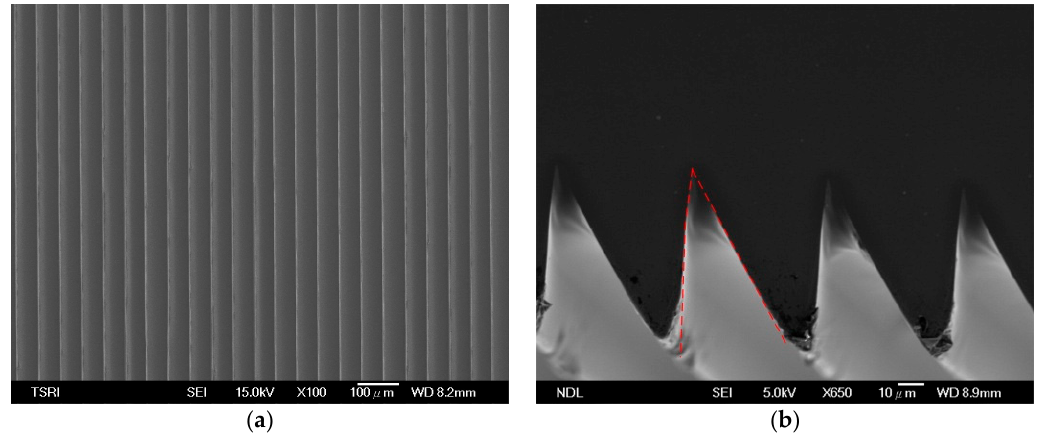
Figure 11. Fabrication result of sunlight guiding panel. ( a ) Top and ( b ) cross-sectional SEM views. Table 1. Comparing the feature sizes of the electroless nickel mold and sunlight guiding panel. Features